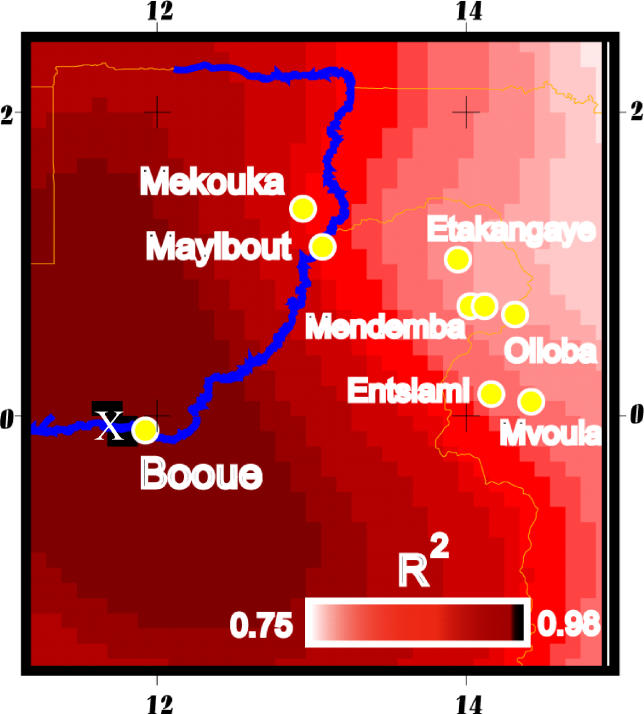
Epizootic Pivot PointShading of each grid cell indicates the strength of correlation (R2) between geographic distance and patristic genetic distance when that grid cell (rather than Booué) is used as the epizootic pivot point. The position of the best fitting pivot point (shown with a white X) along the Ogooue River (blue line) is consistent with a river crossing near Booué, with subsequent movement east toward the Mendemba area. It is not consistent with gene flow directly between the other mid-1990s outbreak localities (Mekouka and Mayibout) and Mendemba.